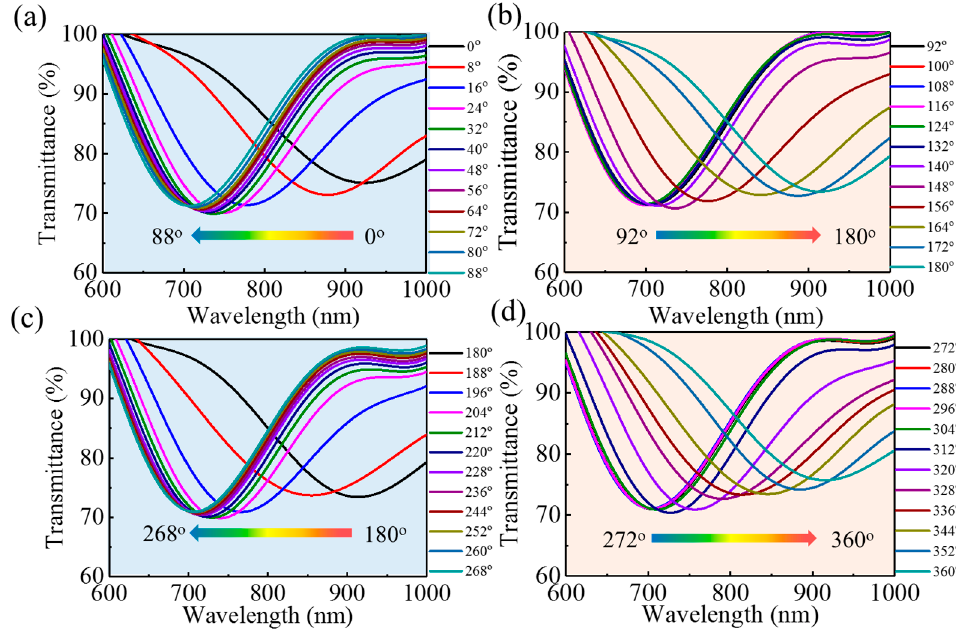
Figure 7. Spectral response of sensor to orientation of magnetic field. The magnetic-field intensity is fixed at 300 Oe, while the orientation is changed ( a ) from 0 ◦ to 88 ◦ , ( b ) from 92 ◦ to 180 ◦ , ( c ) from 180 ◦ to 268 ◦ , and ( d ) from 272 ◦ to 360 ◦ .